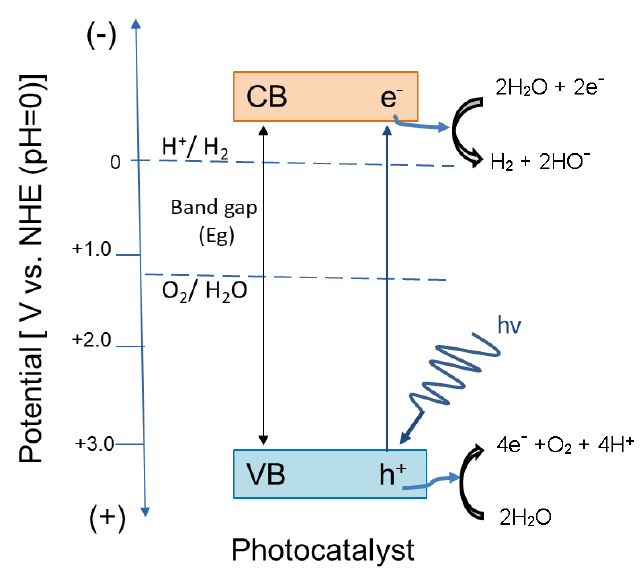
Figure 12. The ideal VB and CB positions for water splitting reaction. Adapted from reference [168].